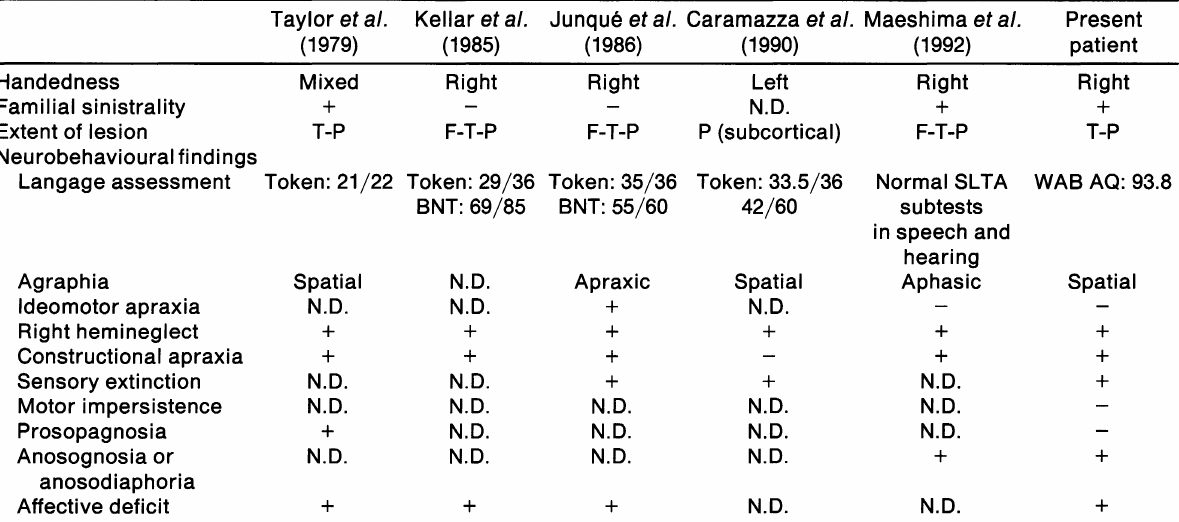
TABLE II. Reported patients with left-sided lesions who showed non-dominant hemisphere signs and no aphasia Taylor et al. Right